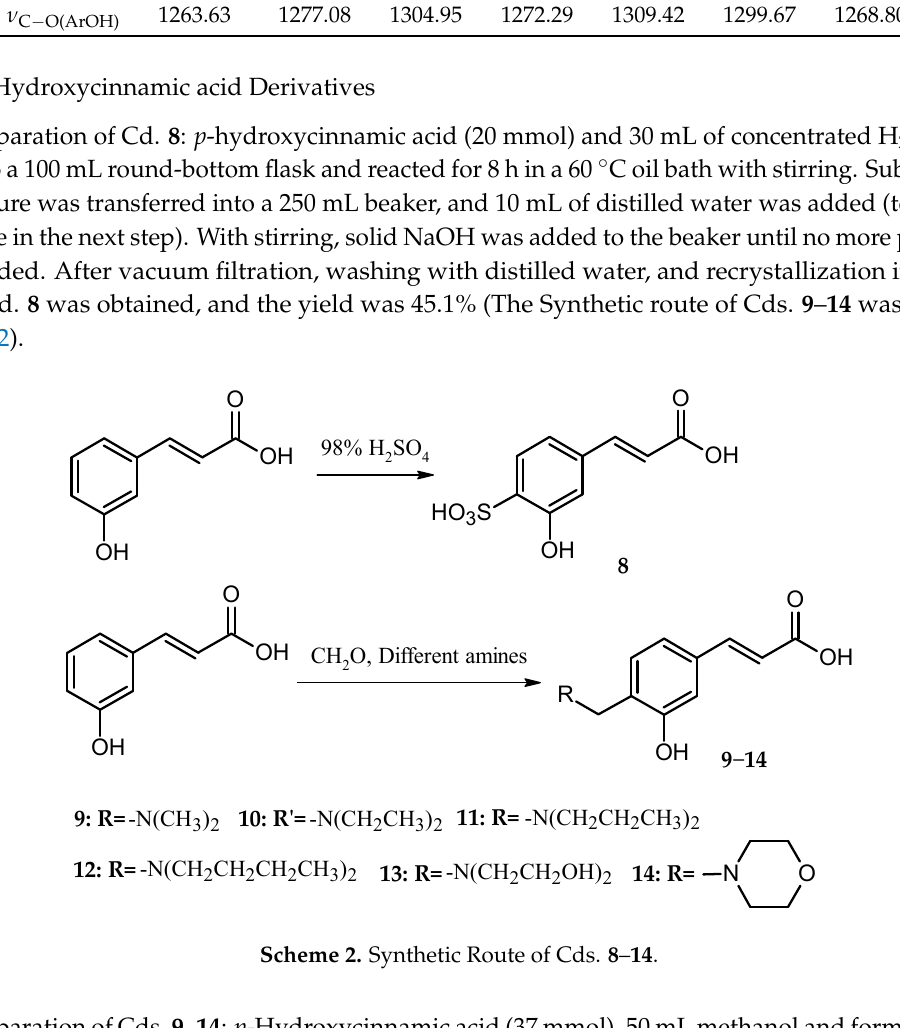
Scheme 2. Synthetic Route of Cds. 8 – 14